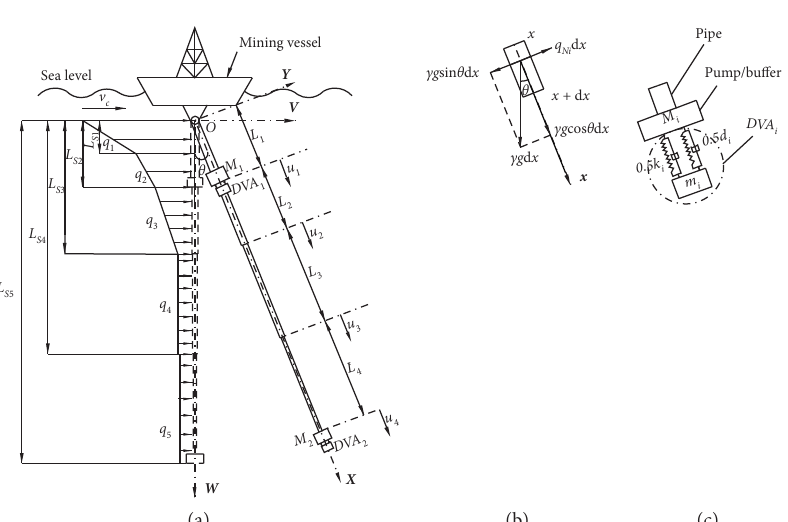
Figure 1: Physical model of the lifting